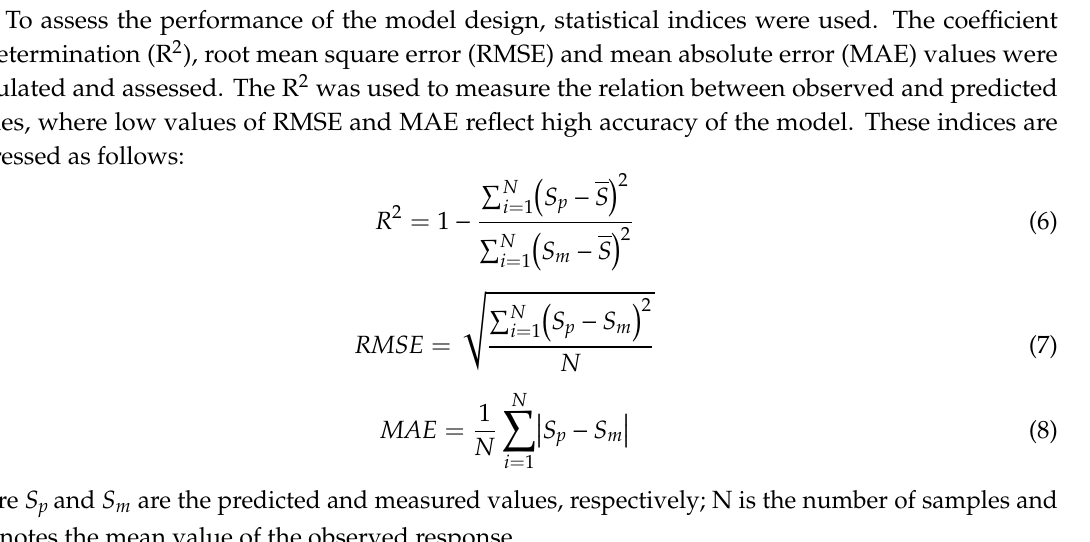
Figure 2. Model process and evaluation.